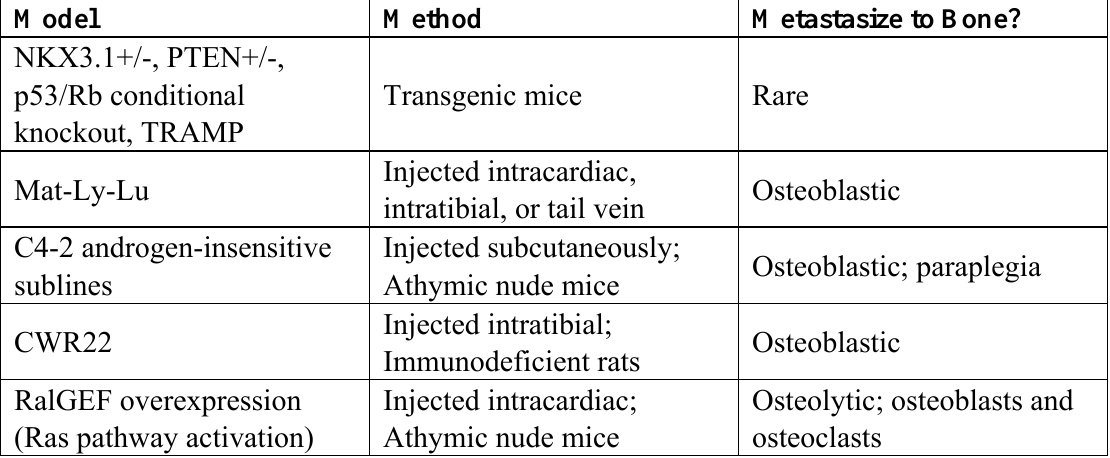
Table 1. Overview of Selected Animal Models of Prostate